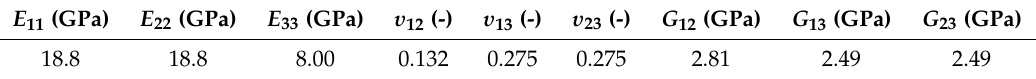
Table 2. Composite [0 ◦ /90 ◦ ] laminate elastic